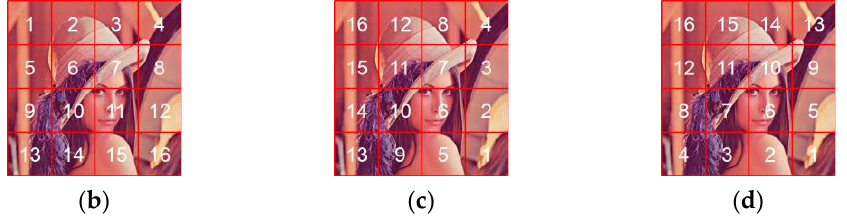
Figure 5. The four options for the Order parameter for patches created in sliding mode: ( a ) column (default), ( b ) row , ( c ) columnrev , and ( d ) rowrev .